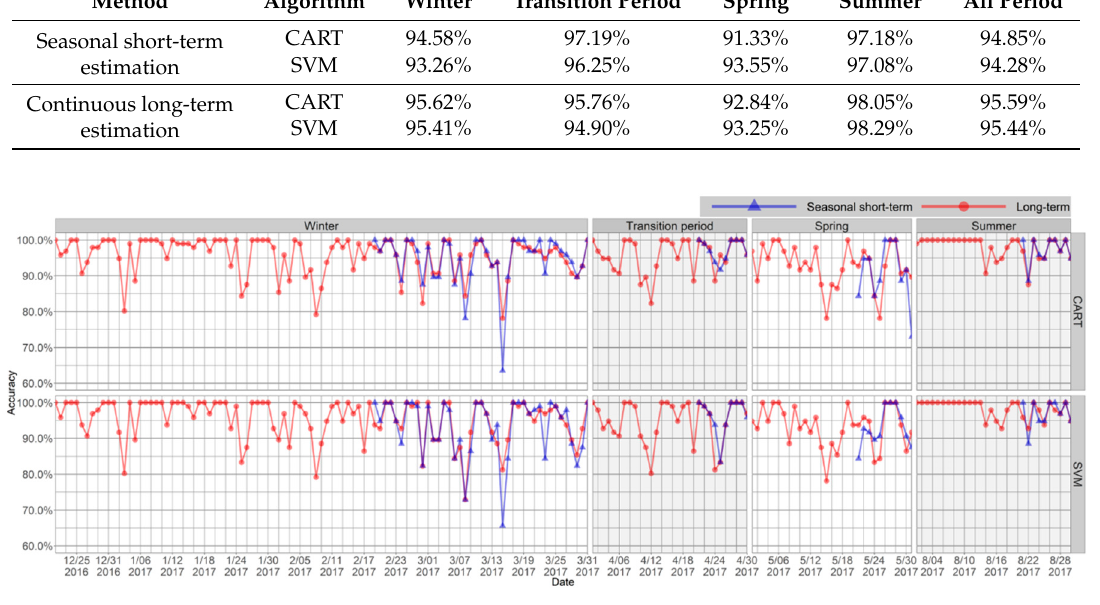
Figure 9. Comparison of daily accuracy over the entire period between short-term and long-term occupancy estimation methods.